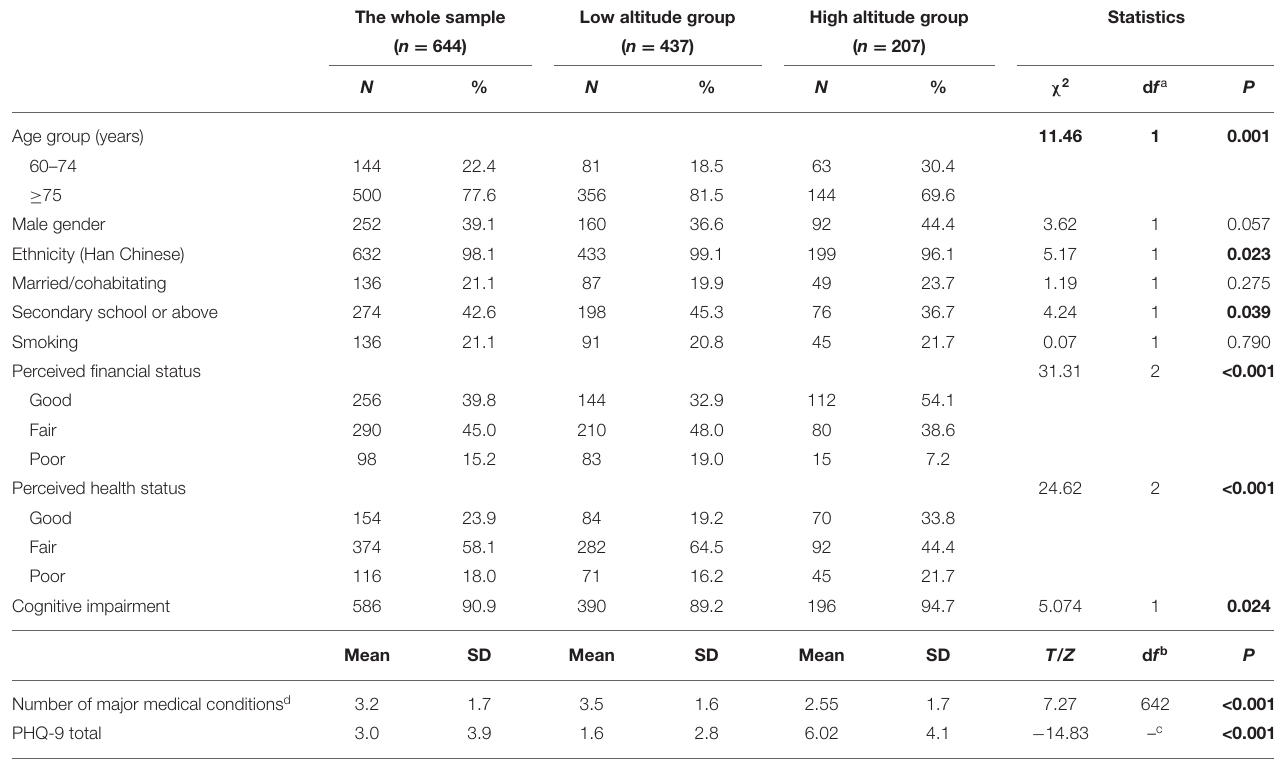
TABLE 1 | Basic demographic and clinical characteristic of the whole sample. The whole sample Low altitude group High altitude group